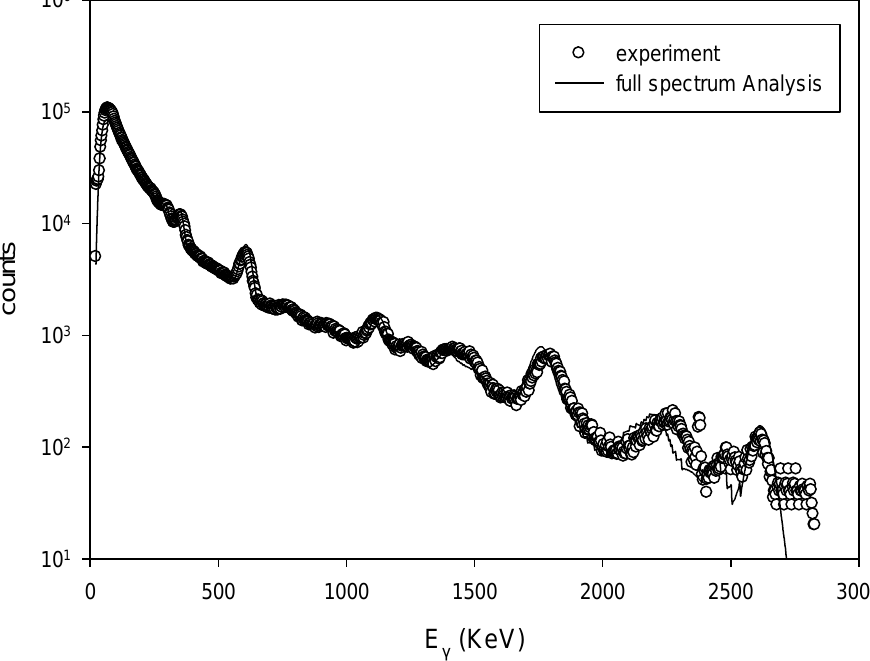
Figure 6. The measured and simulated spectra for estimating concentrations using the FSA method. In the Y -axis, the counts represent the detected events in each gamma-ray energy.